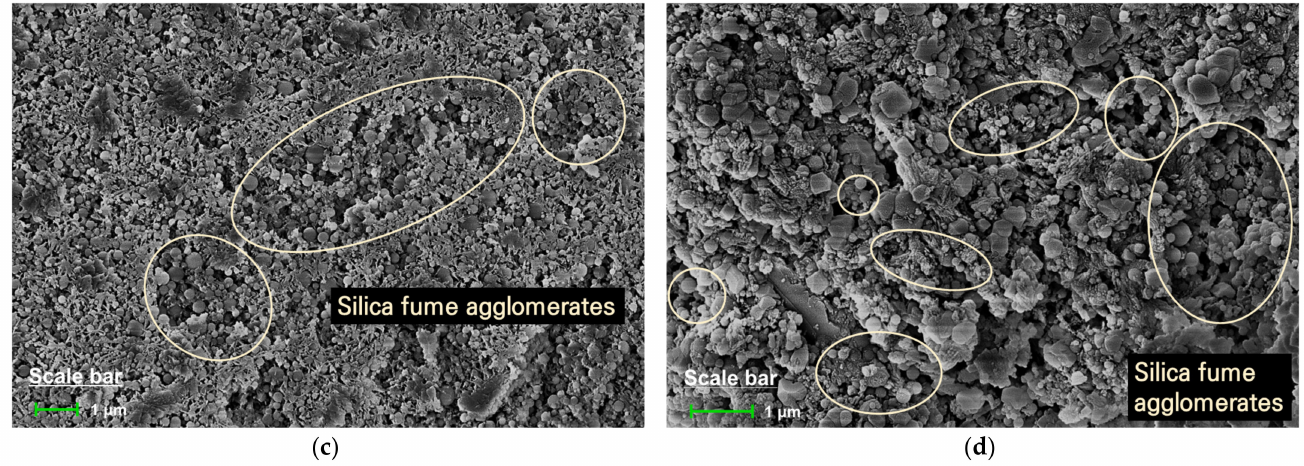
Figure 9. SEM images of SF particles in the cement matrix: ( a ) S10 specimen at 3 days; ( b ) S10 specimen at 28 days; ( c ) S30 specimen at 3 days; ( d ) S30 specimen at 28